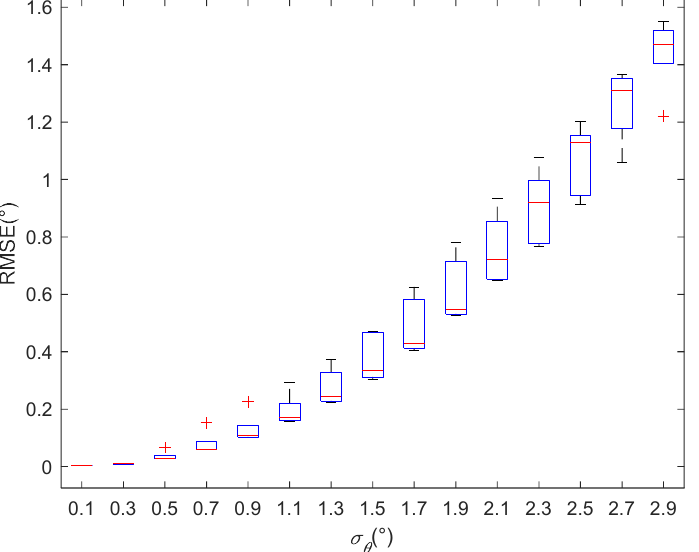
Figure 13. The elevation angle’s estimate accuracy varies with the standard deviation of the angle’s error for the proposed method.